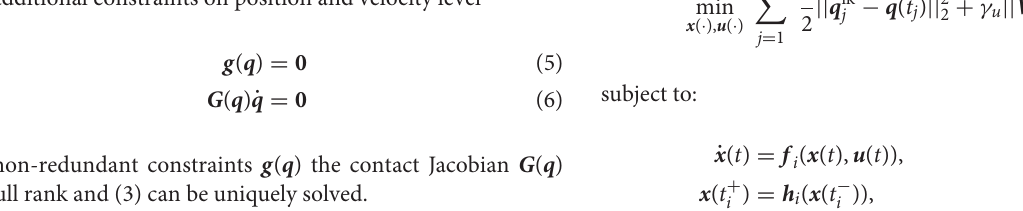
and additional constraints on position and velocity level